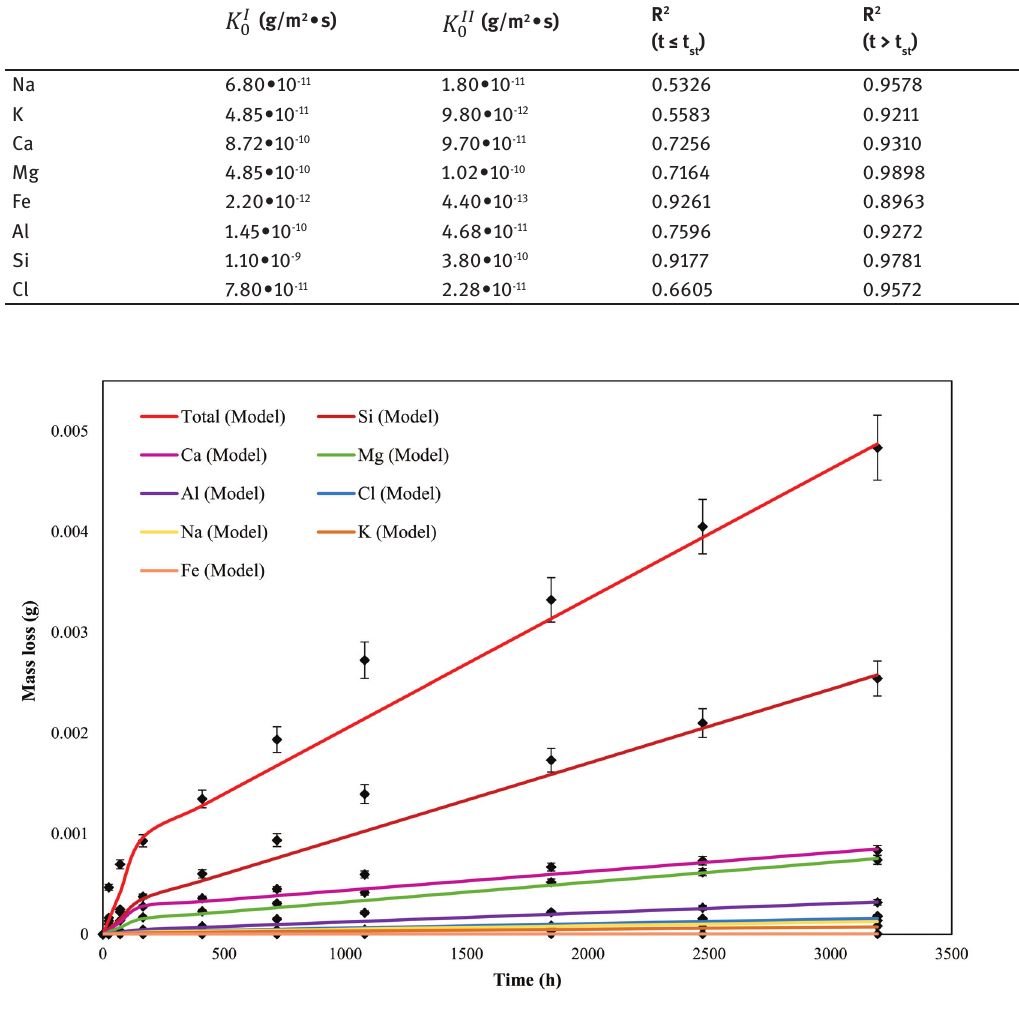
Figure 3: Experimental data and predicted ion release and total mass loss